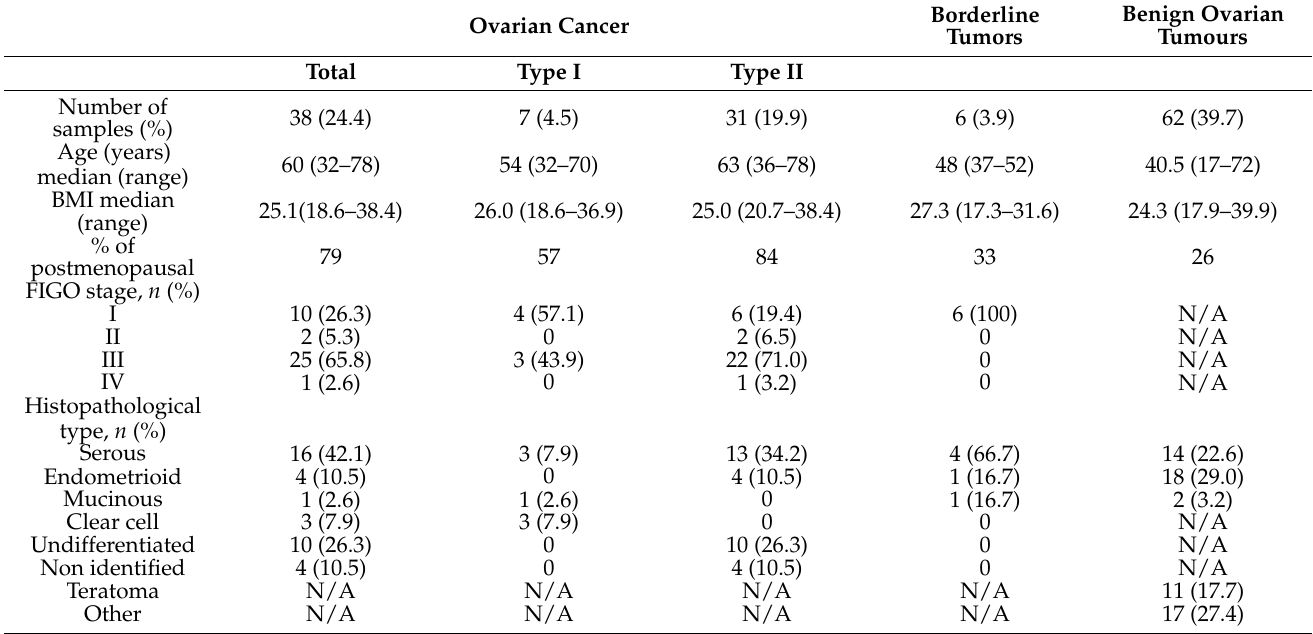
Table 2. Study group